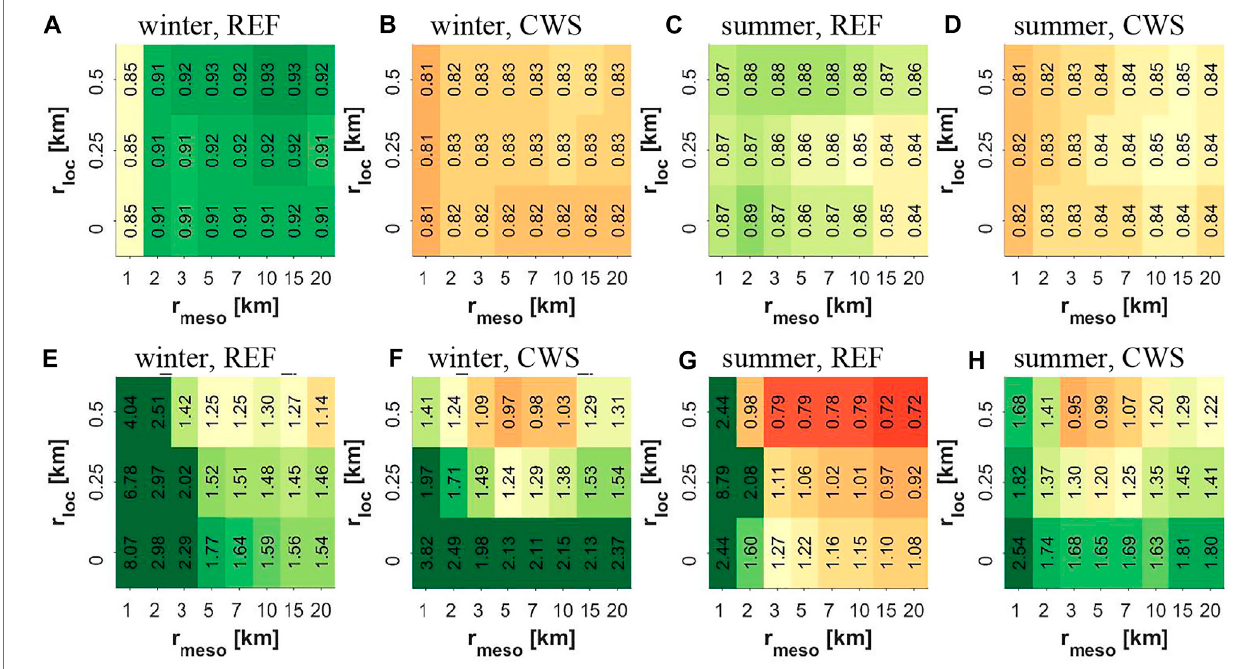
FIGURE 9 | Values of R reg (A – D) and P meso / P loc ratio (E – H) , averaged over the 25% of best combinations for each pair of r loc and r meso for winter (A, B, E, and F) andsummer (C,D,G, and H) periods,REF (A,C,F, and G), andCWS (B,D,F, and H) data.Zero r loc valuesmeanusingthedataontheoriginal250-mgrid.Thecolorsof the cells correspond to the values. Note the different color ranges in sub fi gures (A – G) , compared with sub fi gures (E – H) .